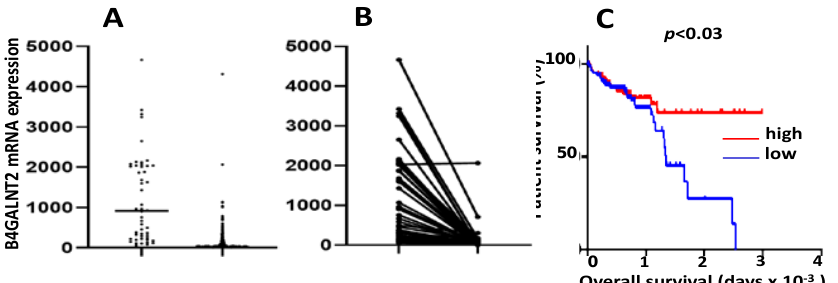
Figure 3. B4GALNT2 mRNA in TCGA COADREAD (colon and rectal adenocarcinoma) cohort. ( A ): unpaired distribution of B4GALNT2 expression in 49 normal samples and 626 cancer samples. Statistical analysis was conducted by the Mann–Whitney test. ( B ): B4GALNT2 distribution in paired normal and tumor tissues of 49 patients. Statistical analysis was conducted by the Wilcoxon test. ( C ): Kaplan–Meier survival curves of patients belonging to the groups of high expressers (15th upper percentile, red) or no expressers (15th lower percentile, blue) of B4GALNT2 mRNA, as deduced from the Oncolnc.org